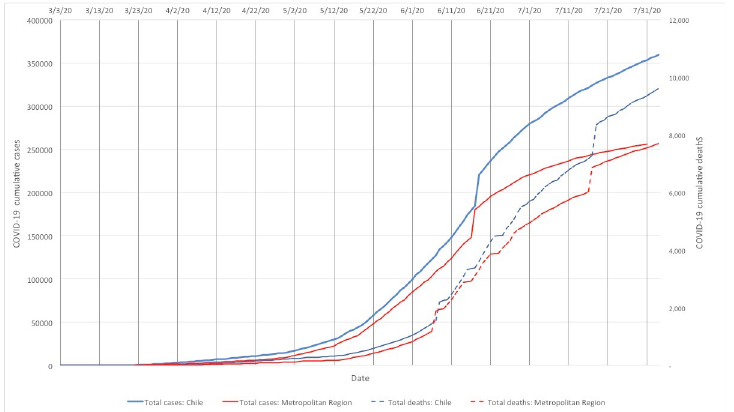
Fig 1. Evolution of cumulative cases, deaths, and policy milestones in Chile and the Metropolitan Region (March- July, 2020).